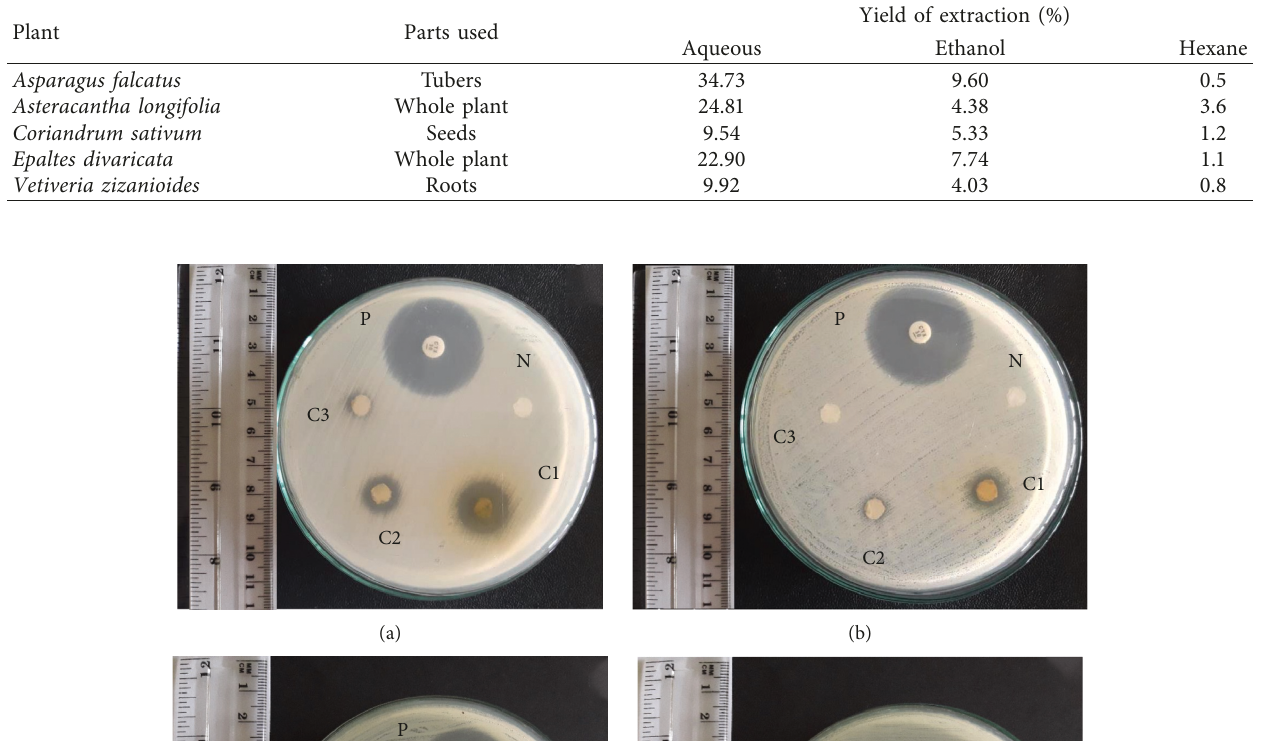
Table 3: Yield of extraction (%) of different extracts of five plants.